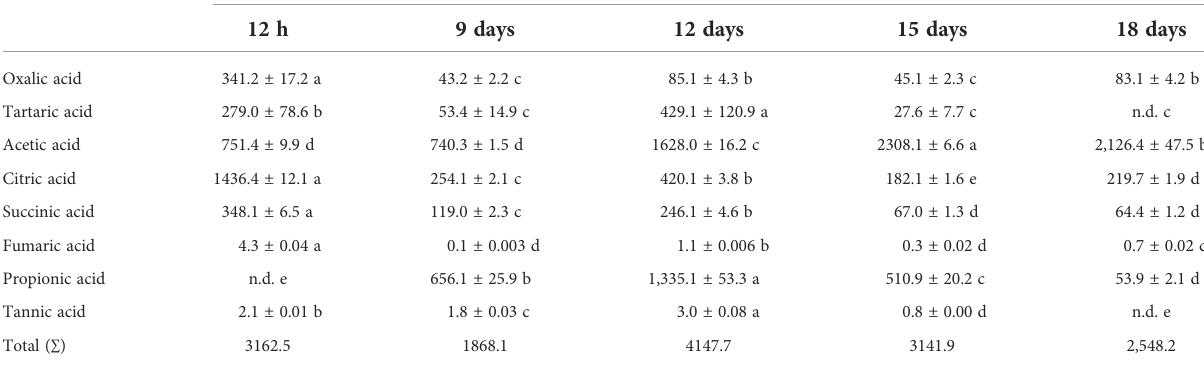
Data represent mean values of three replicates ± SD. Different letters denoted signi fi cantly different (P<0.05) among different decomposition leachates of decay durations. “ n.d. ” indicates that the test and result are below the method detection limit. The detection limits (DL) of tartaric acid, fumaric acid, and tannic acid were 1.7, 0.8, and 0.8 µg ml − 1 respectively. Statistical calculations were performed using one-half of the DL